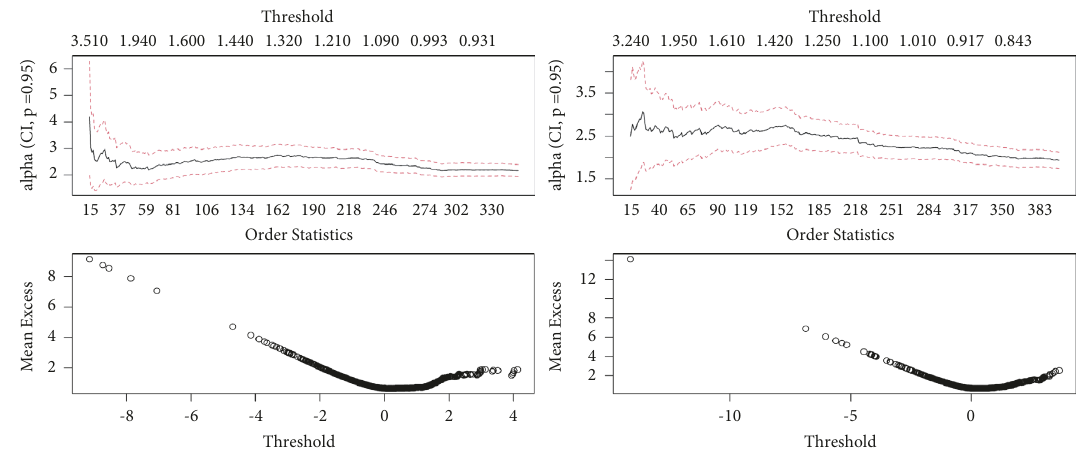
Figure 11: Rapeseed oil-Hill plots and the MEF plots.